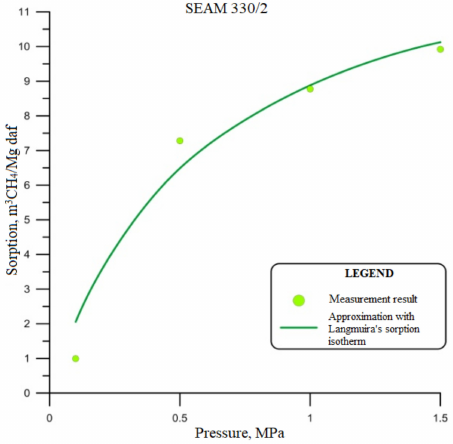
Figure 2. Isotherm of sorption (seam 330/2).